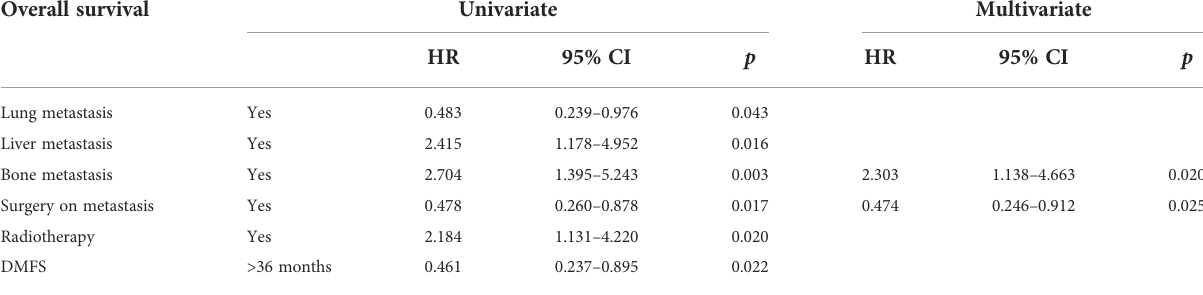
TABLE 3 Prognostic factors of patients with metastatic parathyroid carcinoma according to univariate and multivariate analyses. Overall survival